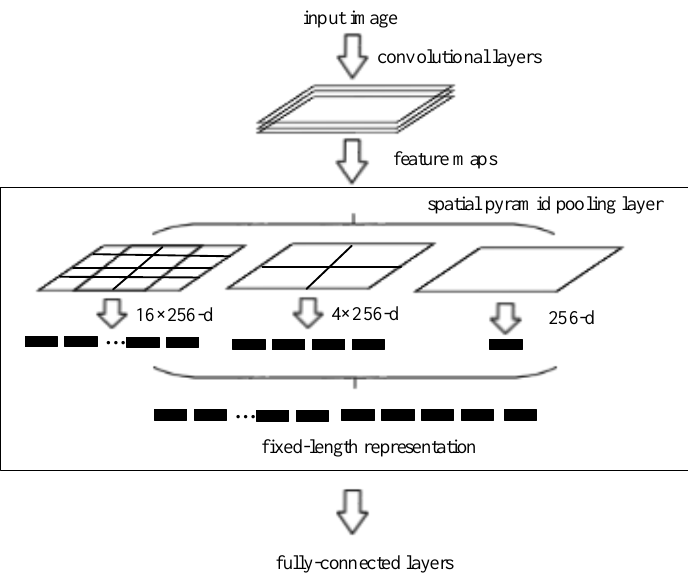
Figure 4. The spatial pyramid pooling layer.